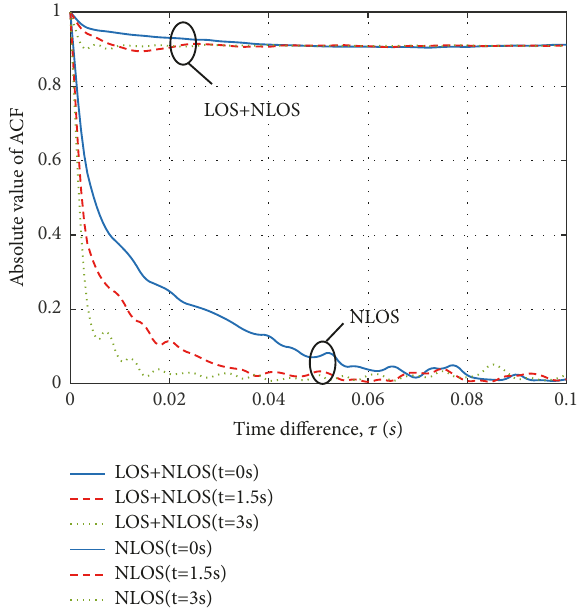
Figure 5: Absolute values of the theoretical TV-ACF |𝑟 𝑝𝑞 (𝑡, 𝜏)| with and without the LOS component at different time